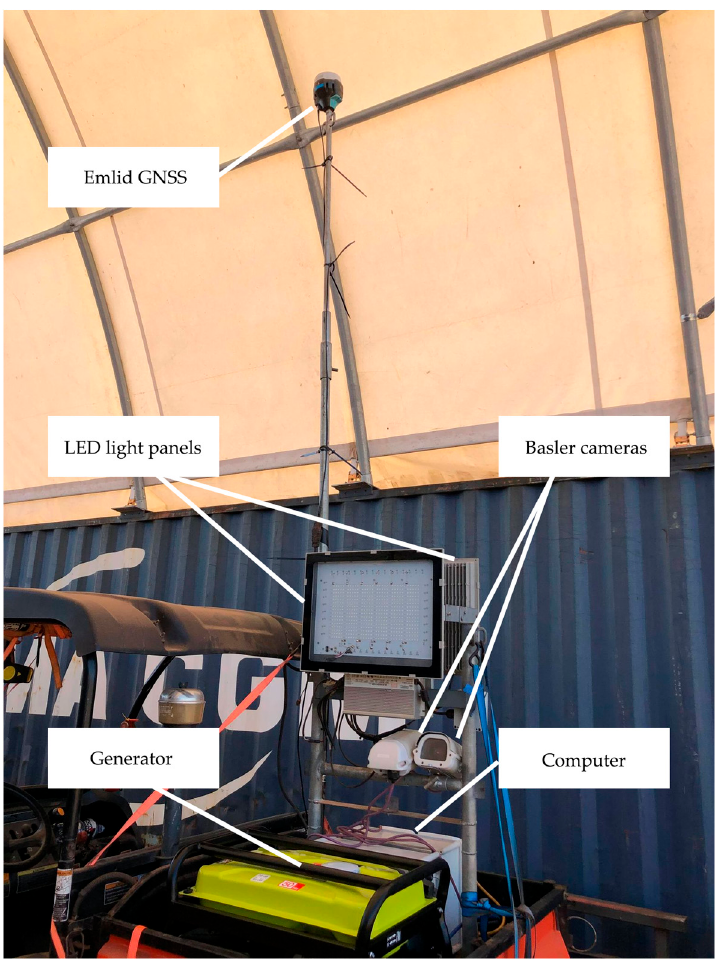
Figure 1. Imaging system, featuring GNSS receiver, LED light panels, two Basler cameras, generator and computer.